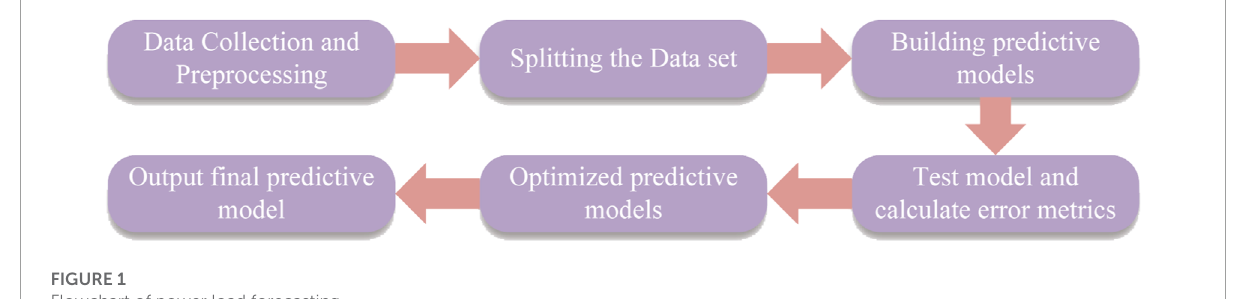
FIGURE 1 Flowchart of power load forecasting.